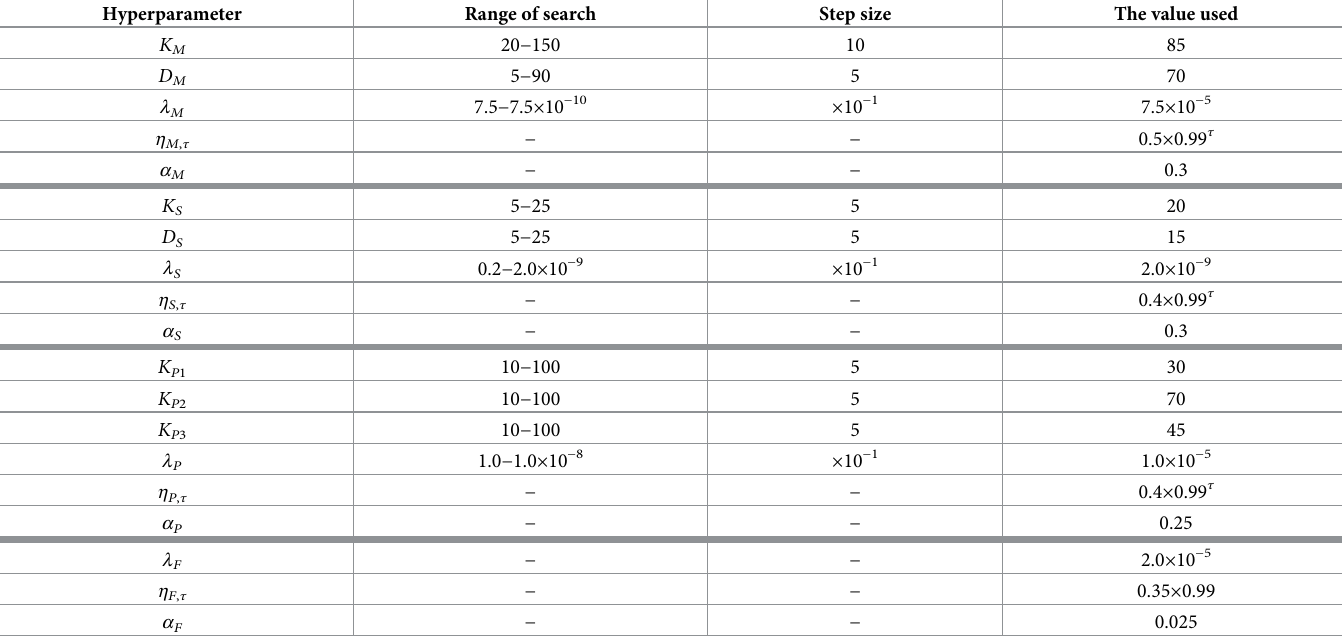
Table 1. Hyperparameters of the odor impression predictive